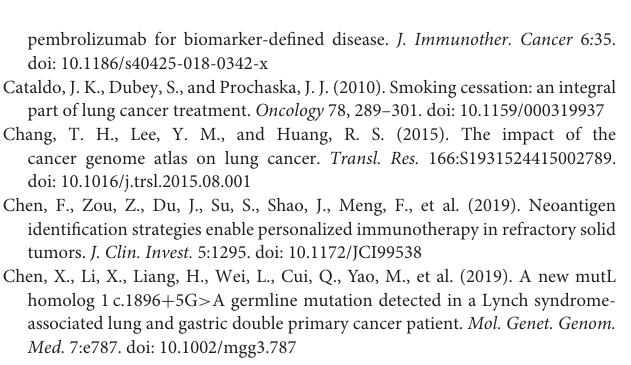
Supplementary Figure 3 | The expression distribution of three types of ICG genes in different data sets. Supplementary Table 1 | Forty seven immune checkpoint genes. Supplementary Table 2 | Enrollment treatment information of patients in TCGA